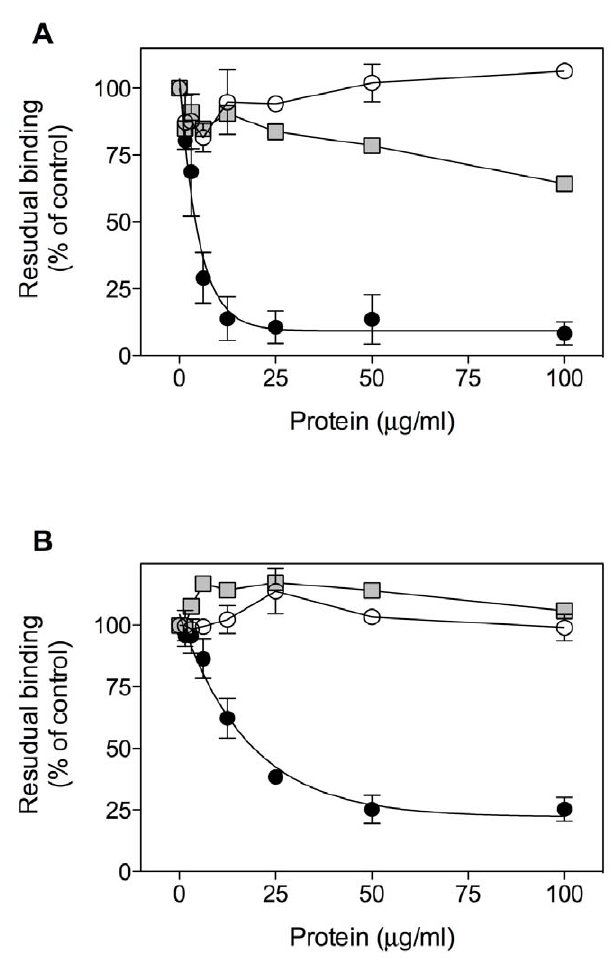
Figure 5. LAIR-2/Fc interferes with VWF binding to collagen. Microtiter wells were coated with 50 m g/ml collagen I ( panel A) or collagen III ( panel B) and subsequently incubated with 0.1 m g/ml purified plasma-derived VWF in the presence of increasing concentra- tions of LAIR-1/Fc (open circles), LAIR-2/Fc (closed circles) or SIRL-1/Fc (squares). VWF binding was detected with horseradish-conjugated polyclonal anti-human VWF antibodies and 3-3 9 -5-5 9 -tetramethylbenzi- dine. Data are representative of 3 independent